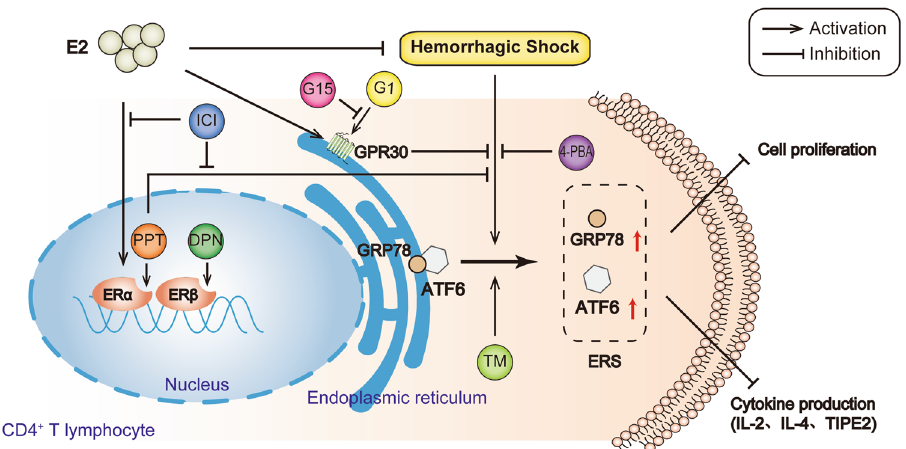
Figure 5. 17β-estradiol (E2) inhibits hemorrhagic shock-induced endoplasmic reticulum stress in splenic CD4 + T lymphocytes via the estrogen receptor (ER) α and G protein-coupled receptor 30 (GPR30). Hemorrhagic shock induces ERS with evidence of an increase in GRP78 and ATF6 expressions and inhibits the proliferation and cytokines production in splenic CD4 + T lymphocytes, which were abolished by E2 treatment through the